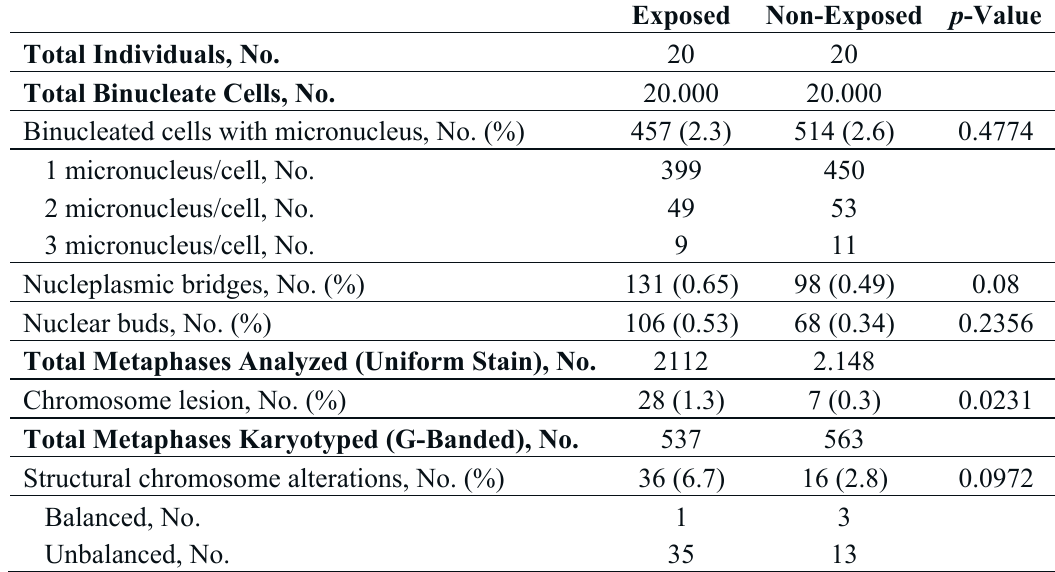
Table 1. Nuclear abnormalities and chromosome damage detected in same individuals exposed and non-exposed to oil.